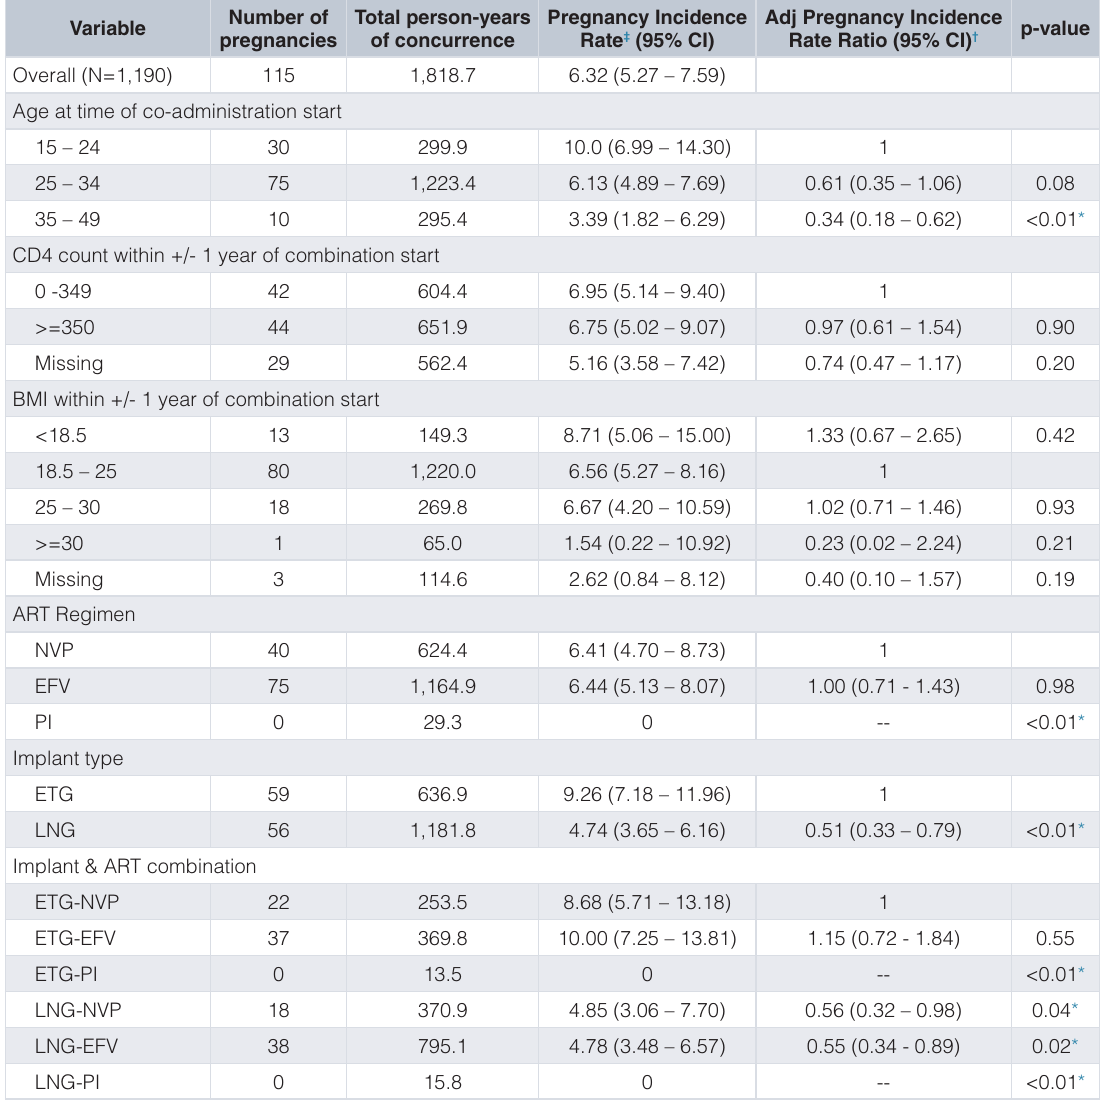
Table 3. Pregnancy incidence rates and incidence rate ratios by clinical